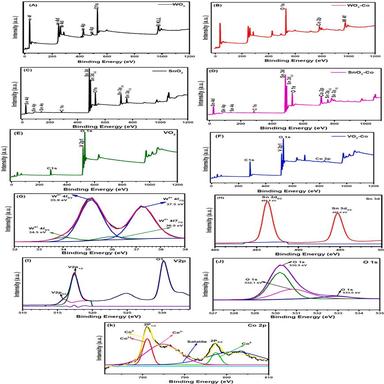
XPS survey scan of WO3 (a), WO3-Co, (b), SnO2 (c), SnO2-Co (d), VO2 (e), and VO2-Co (f). High resolution of w4f (cg), sn3d (h), V2p (l), O1s and their deconvoluted spectra for SnO2-Co (j), as well as Co2p and their deconvoluted spectra for SnO2-Co (k). (For interpretation of the references to colour in this figure legend, the reader is referred to the web version of this article.)